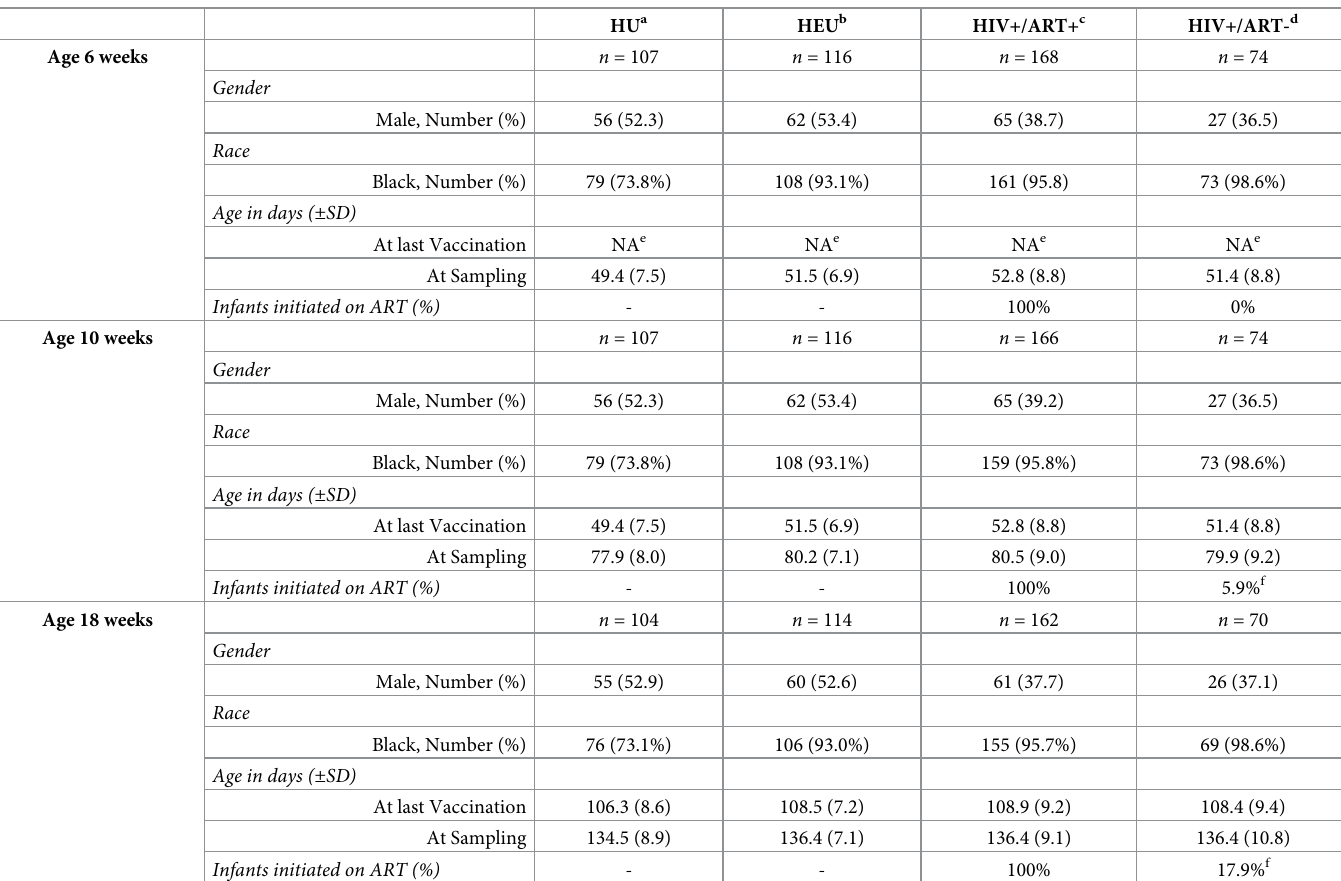
Table 1. Demographical data at 6, 10 and 18 weeks of